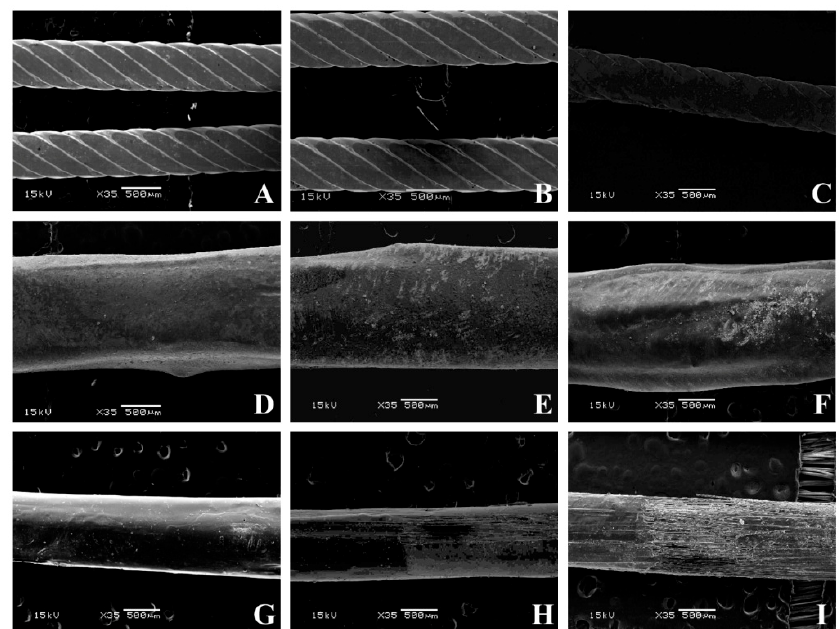
Figure 5. SEM pictures of various conditions tested at 35 × magnification. ( A ) Flat metallic wire not brushed, ( B ) flat metallic wire brushed for 26 min, ( C ) flat metallic wire brushed for 60 min, ( D ) full-bonded FRC not brushed, ( E ) full-bonded FRC brushed for 26 min, ( F ) full-bonded FRC brushed for 60 min, ( G ) spot-bonded FRC not brushed, ( H ) full-bonded FRC brushed for 26 min, ( I ) full-bonded FRC brushed for 60 min.